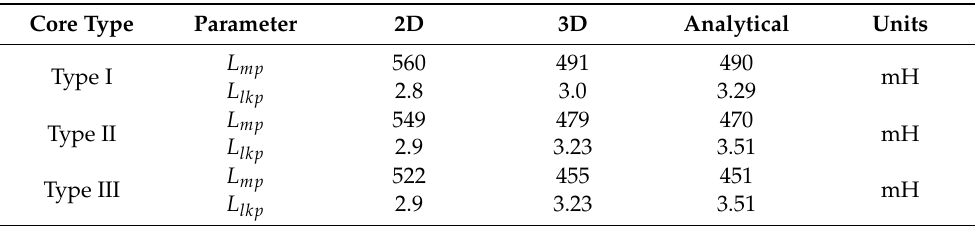
Table 3. Analytical and FEA inductance parameters of the three proposed rotary transformer topologies.